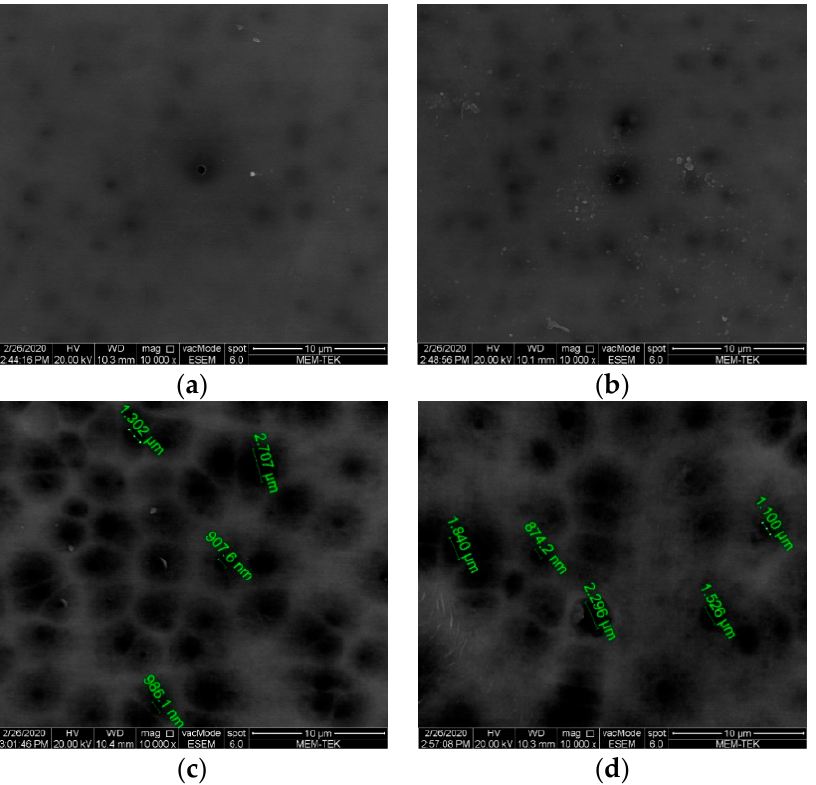
Figure 6. SEM surface images of membranes ( a ) PES 130, ( b ) PES 150, ( c ) PVDF 130, and ( d ) PVDF 150.